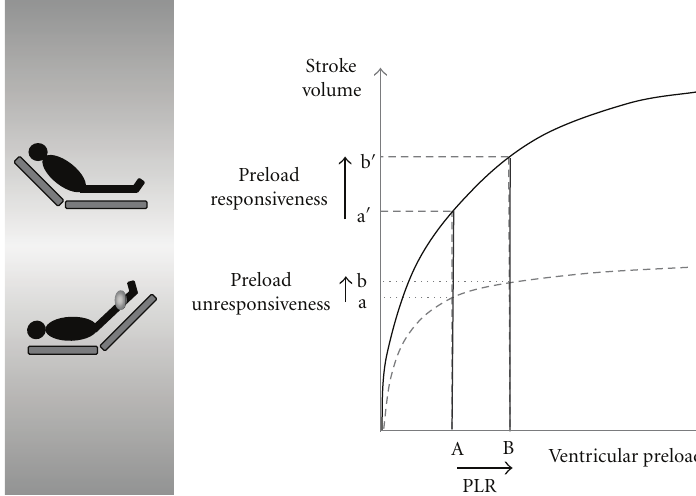
Figure 1: Depending on LV systolic function two distinct families of Frank-Starling relationships are formed, exemplified by solid and interrupted lines. Patients with hemodynamics following solid line pattern (preserved left ventricular systolic function) are more likely to benefit from preload manipulation, then those following the interrupted line pattern (reduced left ventricular systolic function). When Ventricle is functioning on the steep part of the Frank-Starling curve, there is a preload reserve. The passive leg raising (PLR) test (and a fluid challenge) increases stroke volume. By contrast, once the ventricle is operating near the flat part of the curve, there is no preload reserve and PLR (and a fluid challenge) has little e ff ect on the stroke volume.